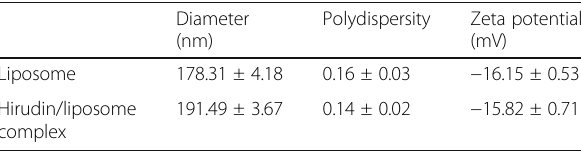
Table 2 Size and Zeta potential of liposome and hirudin/ liposome complex